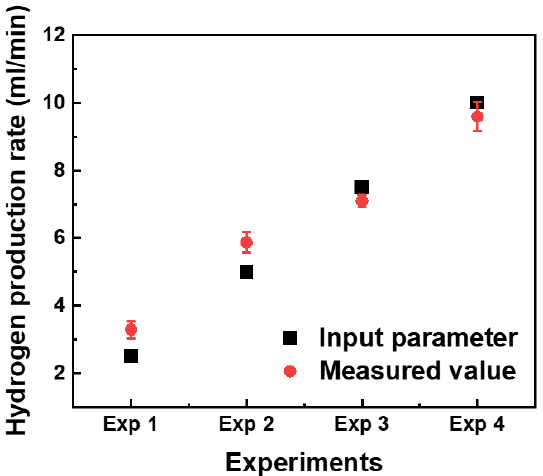
Figure 6. Hydrogen production rate for experiment and ML